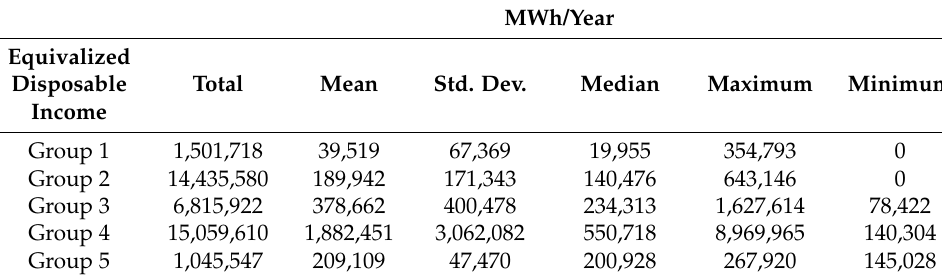
Figure 4. Mean energy consumption by group of cities. Table 3. Statistical data of consumption of the groups.